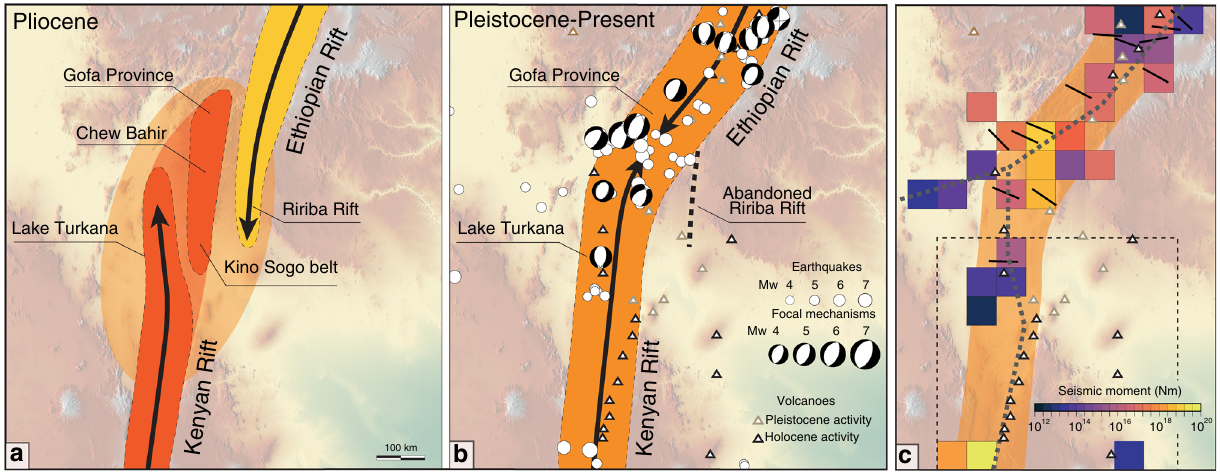
Fig. 5 Evolution of rifting and current distribution of deformation in the Turkana depression. a , b Pliocene-recent schematic evolution of rifting. Coloured patterns in panel a delineate the main domains of tectonic and magmatic activity related to the Ethiopian and Kenyan rifts; the elliptical light orange pattern indicates the hypothesised extension of the region affected by deformation; black lines with arrows indicate the patterns of rift propagation 15 . Earthquakes are from the NEIC catalogue and focal mechanisms from the Global Centroid-Moment-Tensor (GCMT) Project 64,65 (https://www.globalcmt.org). Dotted black line indicates the abandoned Ririba rift. c Sum of seismic moment release of earthquakes from the NEIC catalogue; superimposed are T-axes strike directions from the GCMT moment tensors (black lines). Dashed box indicates the region analysed by the temporary, local seismic networks deployed in northern Kenya 28 . Dotted dark grey line indicates the approximate location of the plate boundary deduced from models of geodetic data in East Africa